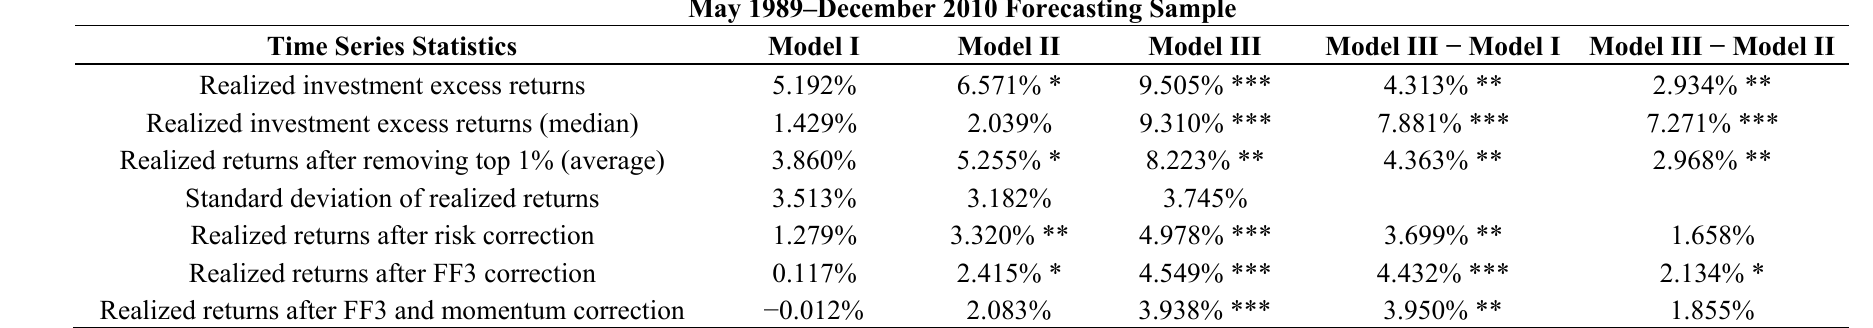
Table 6. Forecasting results for larger